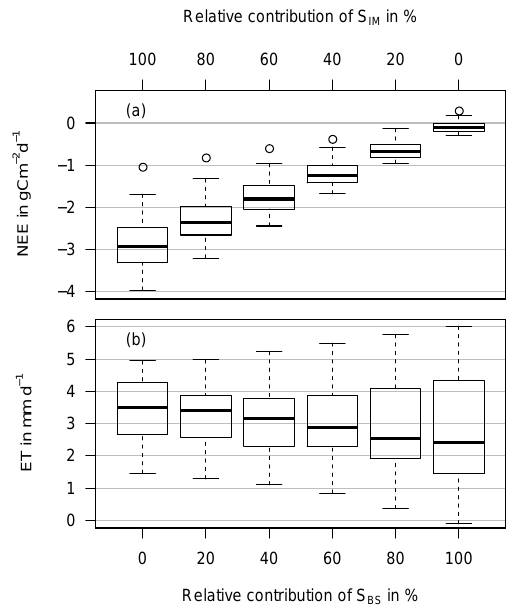
Figure 9. Modelled daily net ecosystem exchange (top, NEE) and modelled daily evapotranspiration (bottom, ET) for 46 days (12 July to 26 August 2012) at Kema (varying combination of S IM and S BS ): box plot with median, 25% and 75% quartiles; bars represent quar- tiles ± 1.5 times interquartile